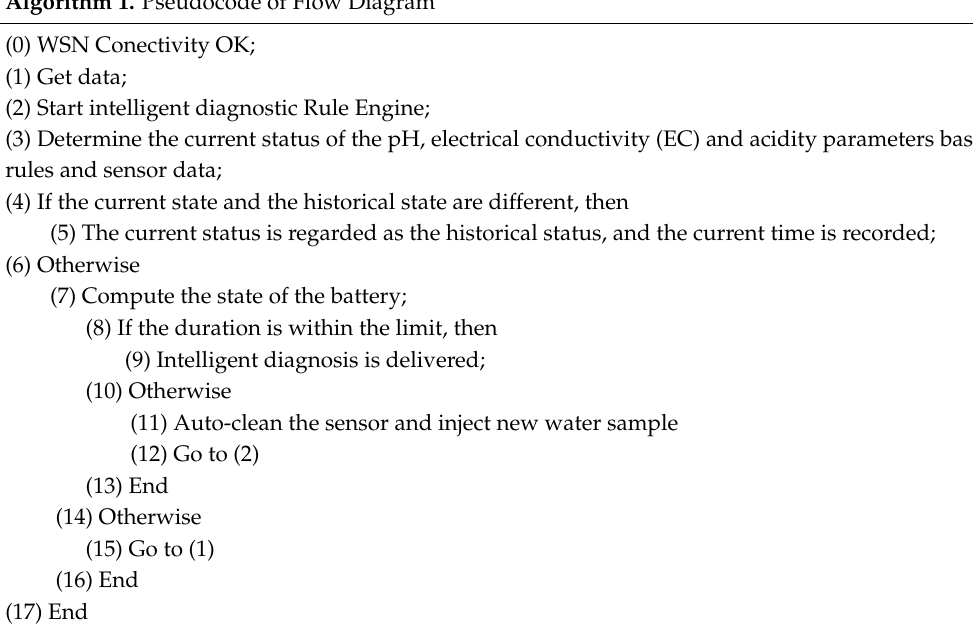
Algorithm 1. Pseudocode of Flow